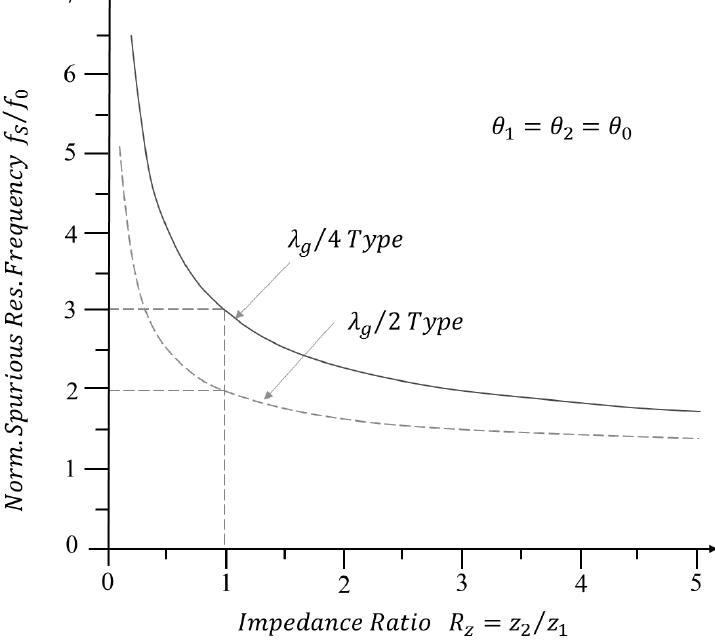
Figure 5. Normalized spurious resonance frequency concerning impedance